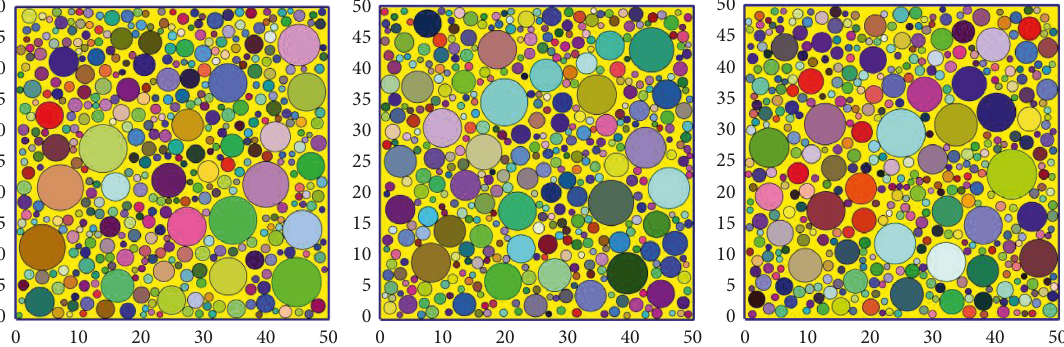
Figure 1: Circular random aggregate models with same geometric parameters ( r